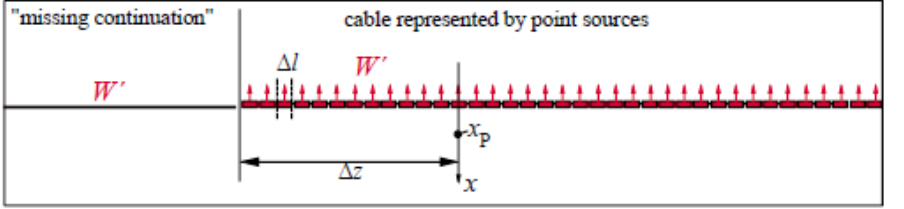
Figure 4. Temperature rise caused by a semi ‐ infinite line source (as the “missing continuation”).